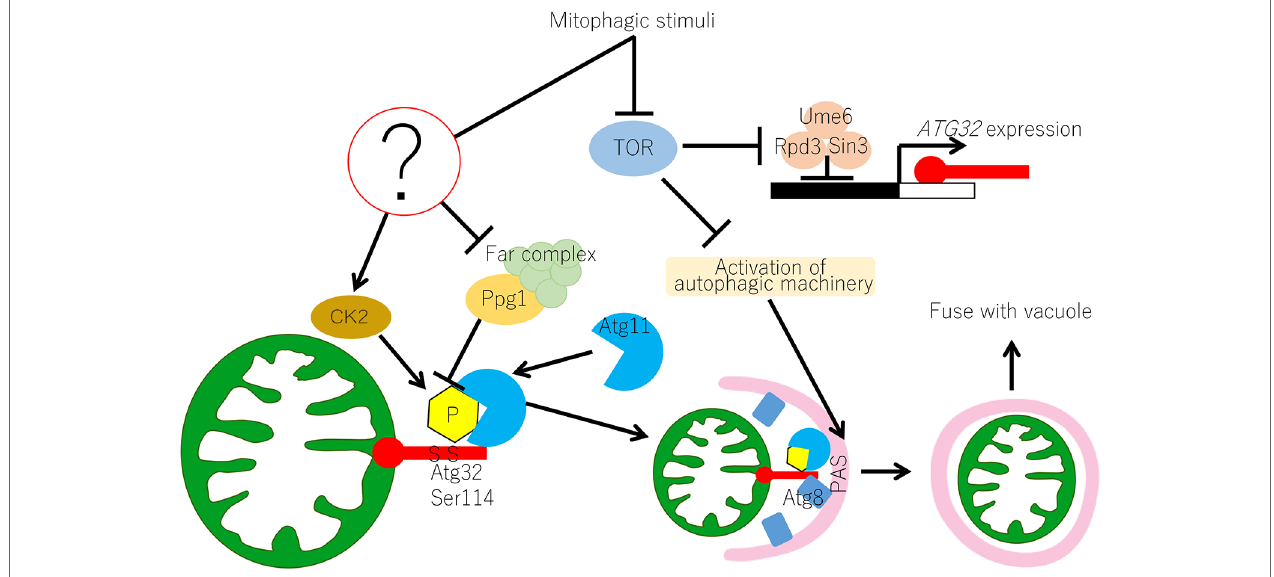
FIGURe 1 | Molecular mechanism of mitophagy in yeast. In yeast, the Atg32-mediated mitophagy is regulated at transcriptional and post-translational levels. Transcription of ATG32 is suppressed by the Ume6–Sin3–Rpd3 complex, which interacts with the upstream repression sequence (URS) of the ATG32 promoter region. Inhibition of TOR releases the Ume6–Sin3–Rpd3 complex and ATG32 can be transcribed. Under normal growing conditions, Ppg1 with the Far complex dephosphorylates Atg32 to prevent unrequired mitophagy. Upon mitophagy induction, the function of the Ppg1-Far complex might be suppressed through unidentified mechanisms and CK2 phosphorylates Atg32 at Ser114 and Ser119. Then, Atg11 interacts with the phosphorylated Atg32 and recruits mitochondria to the PAS. Mitophagy signal also activates the core autophagy machinery, which is recruited to the PAS. At the PAS, Atg32 interacts with Atg8, which anchors on the isolation membrane, and the Atg32–Atg8 interaction facilitates the formation of the autophagosome surrounding the mitochondria. Autophagosome carrying mitochondria eventually fuse with vacuoles for mitochondrial degradation. CK2, casein kinase 2; PAS, phagophore assembly site or pre-autophagosomal structure; TOR, target of